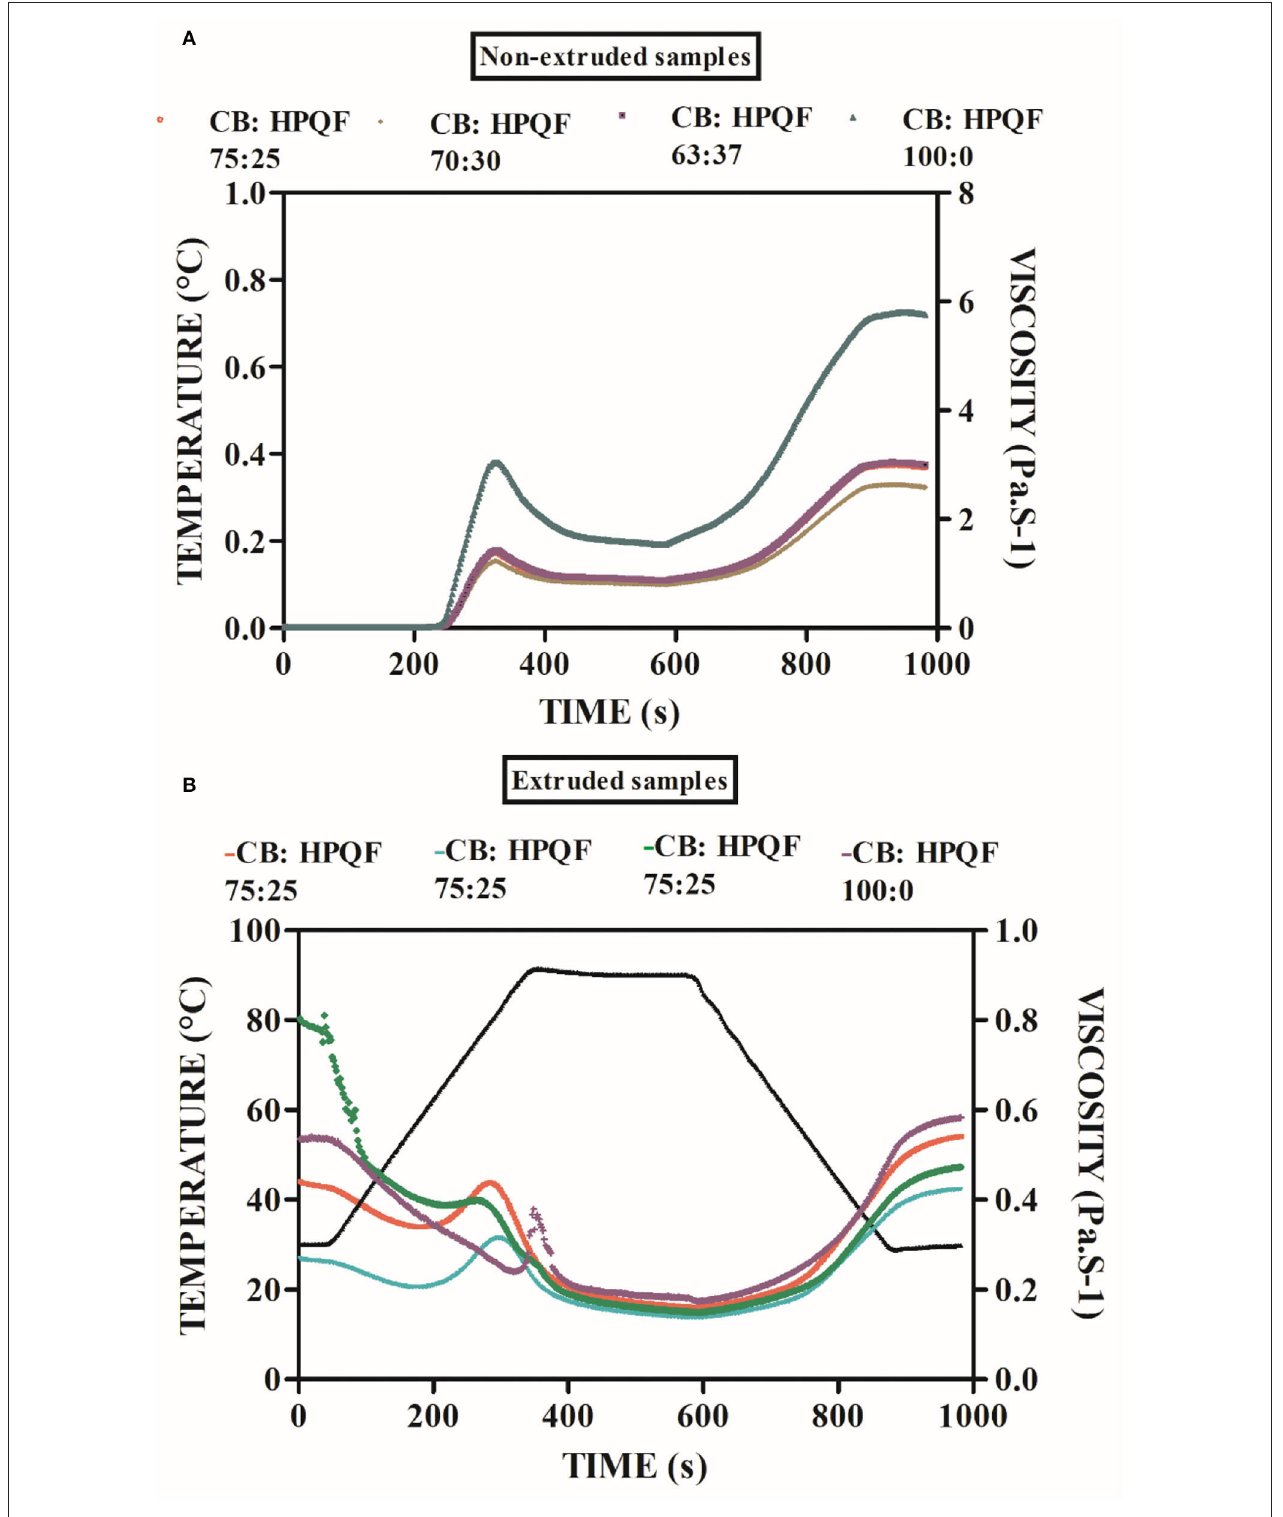
FIGURE 3 | Pasting properties of non-extruded samples (A) and extruded samples (B) , obtained with different amounts of hyper-protein quinoa flour.